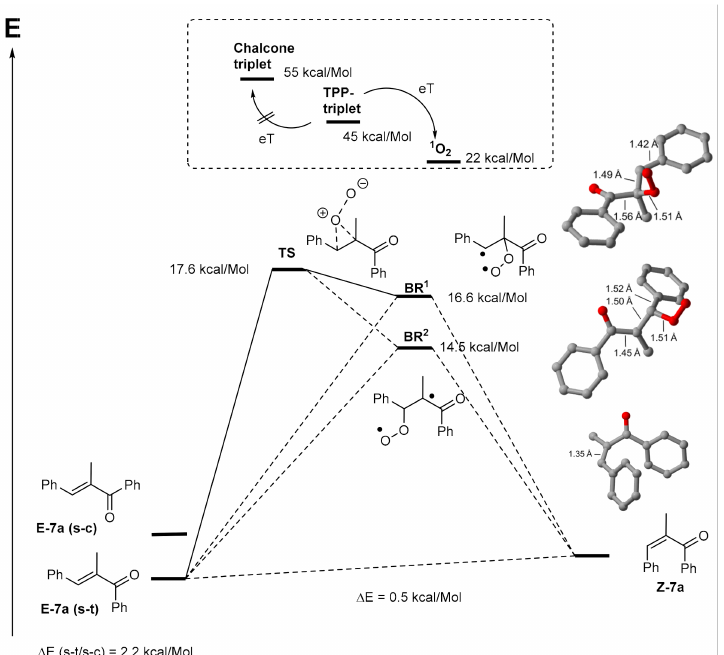
Figure 3. Proposed reaction sequence: energy values from quantum chemical (DFT) calculations (triplet energies and 1 O 2 energies (box) from literature) rotational minima for the Z- 7a isomer, energies, and structures of the biradicals BR 1 and BR 2